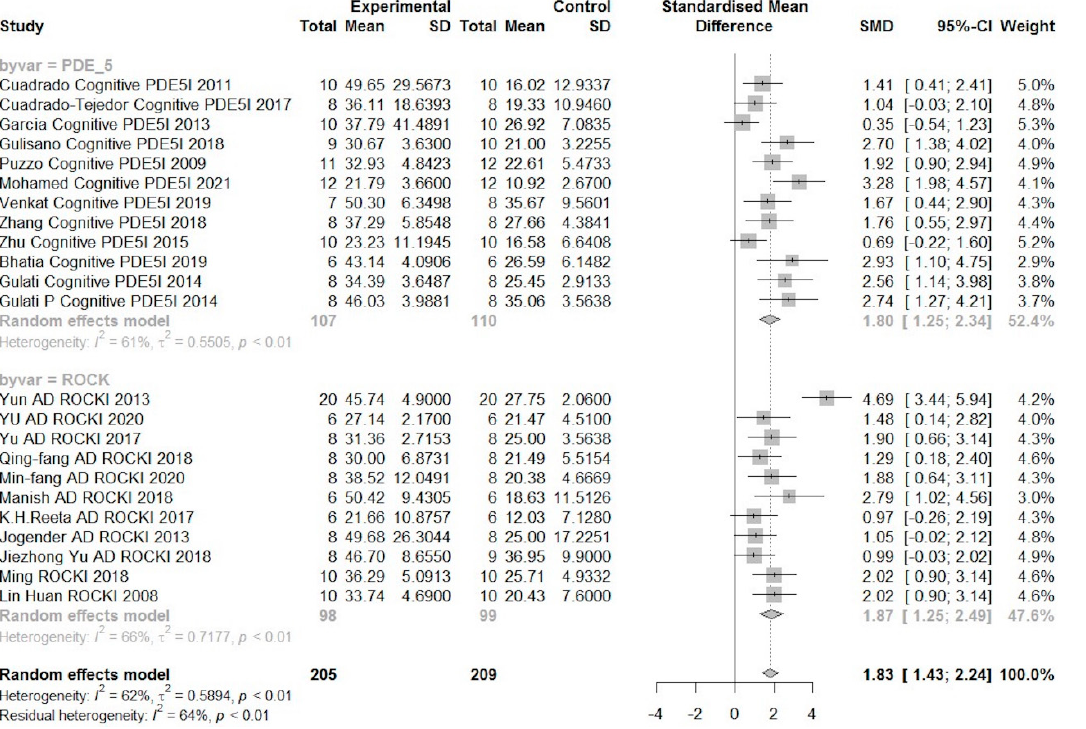
Figure 5. This forest plot shows an analysis of the difference between the experimental group and the control group of each subgroup by standardized mean difference (SMD). Because of the high heterogeneity, each group was analyzed by dividing it into subgroups. SD: standard